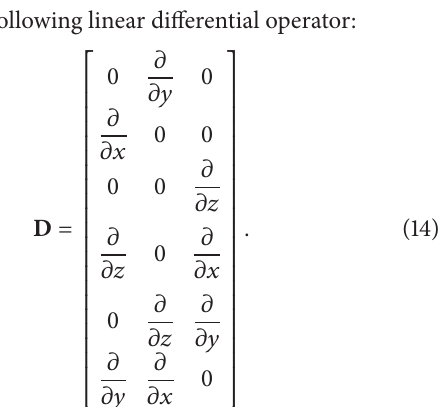
Figure9:Positionofthenon-structuralmassatthetipcross-section of the C-shaped